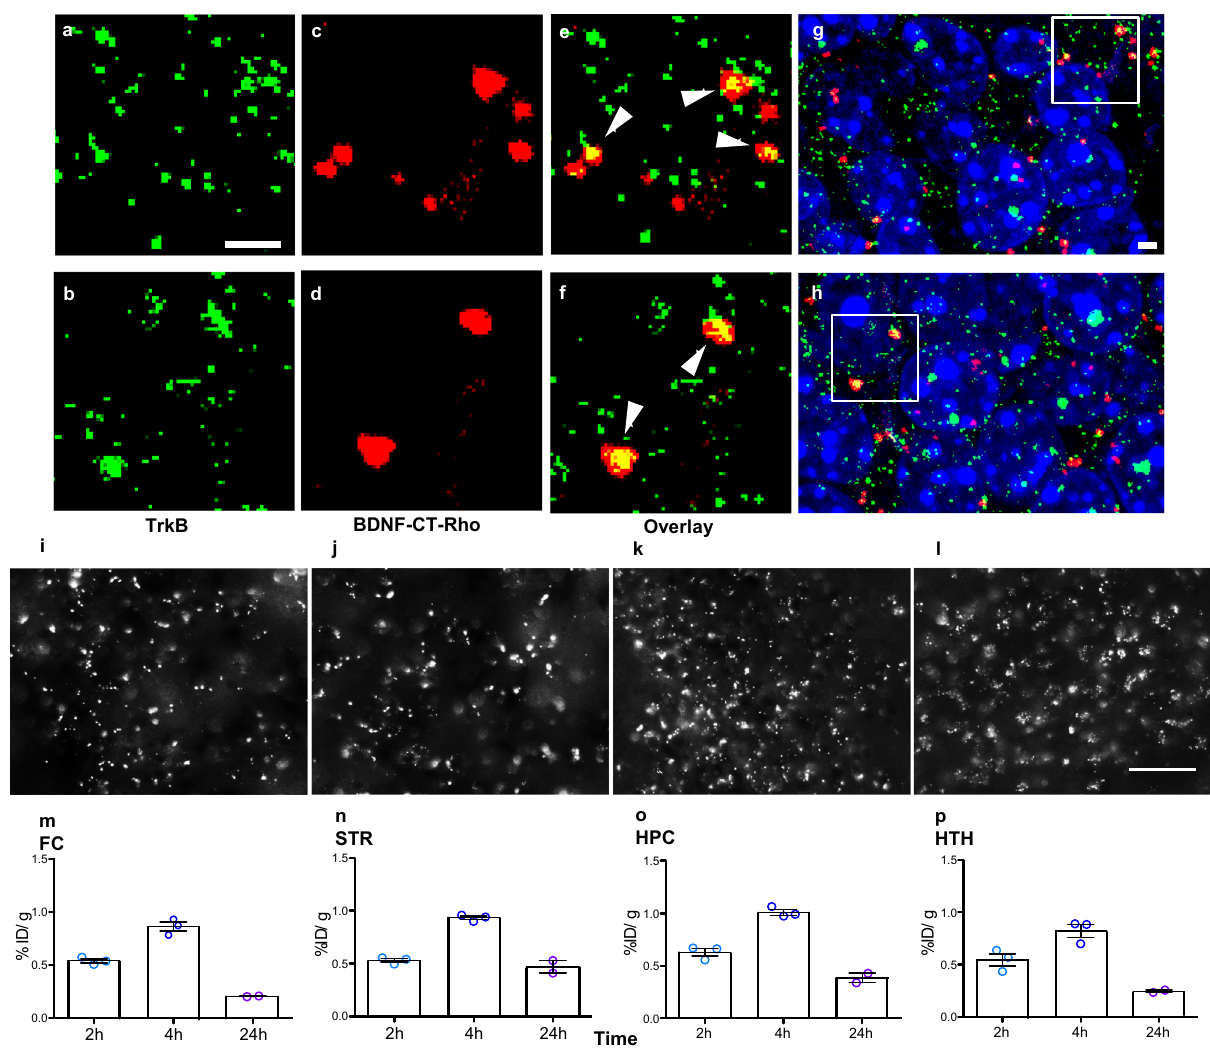
Fig. 2 CT ef fi ciently delivered BDNF to TrkB receptors in the mouse brain. Tat + mice were given a single dose of i.n. BDNF-CT-Rho (0.3 mg/kg of BDNF and 2.4 mg/kg of CT). Brains were collected after 4 h. Brain sections were probed for TrkB and visualized using Alexa Fluor 488. Confocal microscopy shows TrkB receptors (green) ( a , b ) and intranasally delivered BDNF-CT-Rho (red) nanoparticles ( c , d ). BDNF-CT-Rho are co-localized with TrkB receptors (yellow) ( e , f ). Images were taken from two DG locations (box; g , h ). Scale bars are 2 µ m. Representative images of the BDNF-CT-Rho are shown in the frontal cortex (FC) ( i ), striatum (STR) ( j ), hippocampus (HPC) ( k ), and hypothalamus (HTH) ( l ). Brains were also collected from Tat + mice at 2, 4, and 24 h after i.n. [3] H-BDNF-CT NP administration. Tissue concentrations of radioactive [3] H-BDNF-CT were assessed. The peak concentrations of BDNF-CT ID/g) of tissue ( n = 3/group and for 24 h n = 2/group). Error bars represent S.E.M. The scale bar is 50 µ